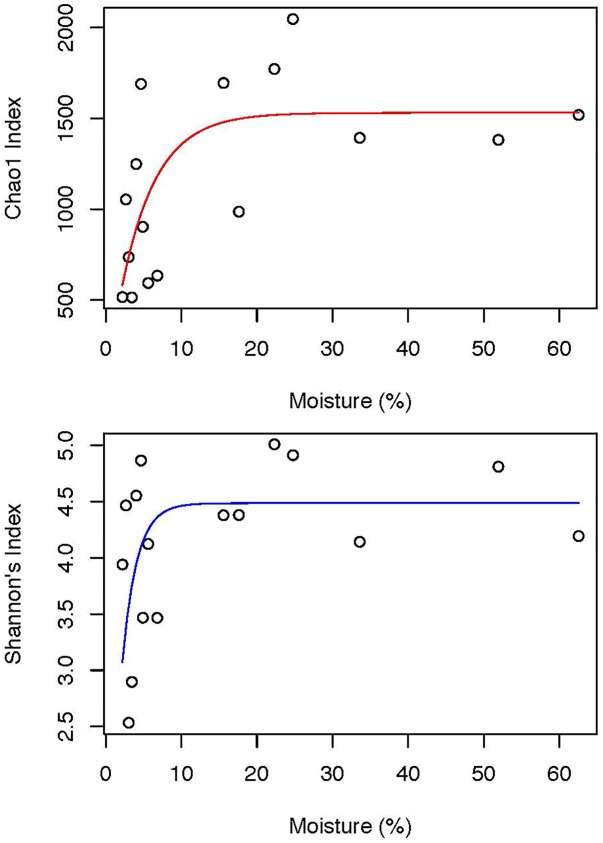
Asymptotic trends of Chao1 species richness estimator (Adj R2 = 0. 0.3875, p = 0.00278) and Shannon’s diversity index with soil moisture content (Adj R2 = 0.0679, p = 0.02748). For more detailed description of the models, please refer to Table 2.